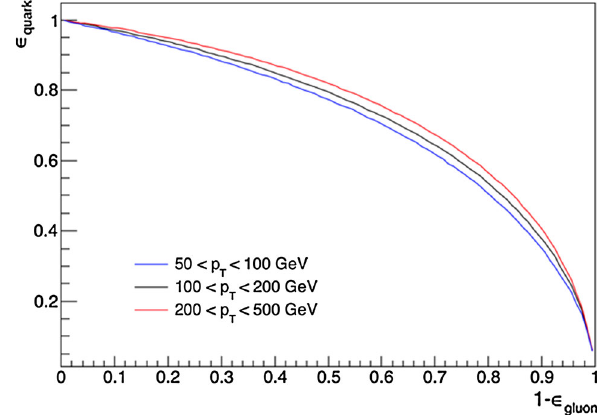
Fig. 7 Performanceofapossiblenewquark–gluontagger(using p T D , σ 2 , and the EFOs), in three p T bins, for Herwig-generated dijet events. Quarks and gluons are found to be easier to distinguish using this tagger at higher p